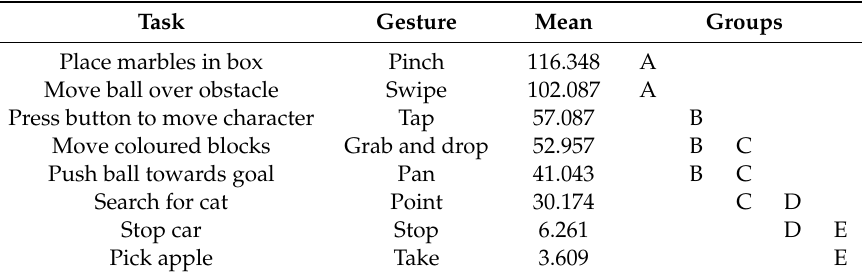
Table 9. Groupings of gestures by completion times.